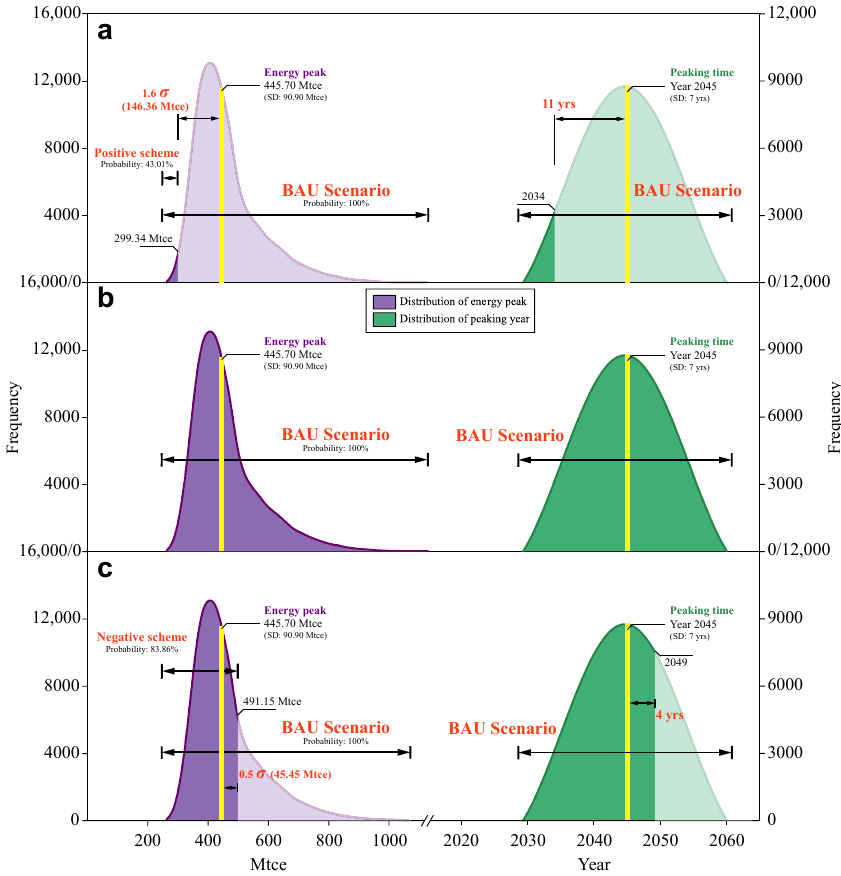
Figure 8. Energy benchmark with its peak status of future commercial building operations in schemes: ( a ) positive, ( b ) normal (BAU scenario), and ( c ) negative.